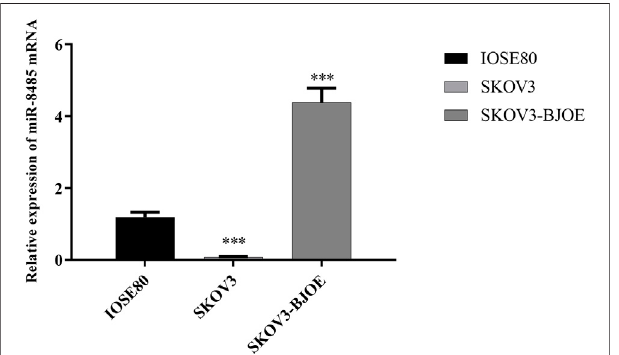
FIGURE 2 | Expression of miR-8485 in different ovarian cells. (SKOV3 group wascomparedwithIOSE80group(n=3). Datawereshownasmean± SD,*** p < 0.001;SKOV3groupwascompared withSKOV3-BJOEgroup(n= 3). Data were shown as mean ± SD, *** p < 0.001).